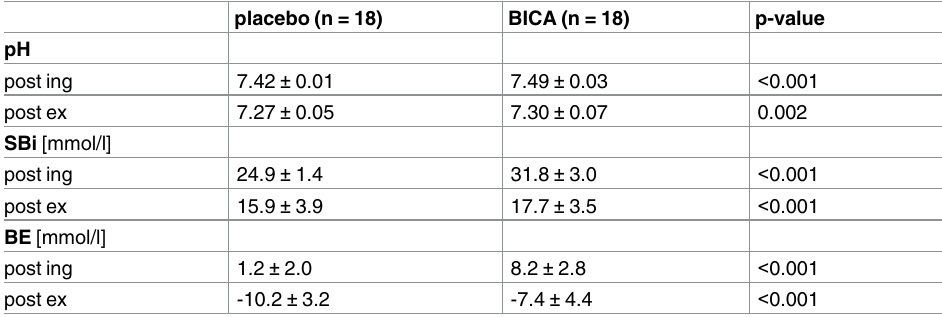
Table 2. Blood gas parameters during exhaustive graded exercisetest.